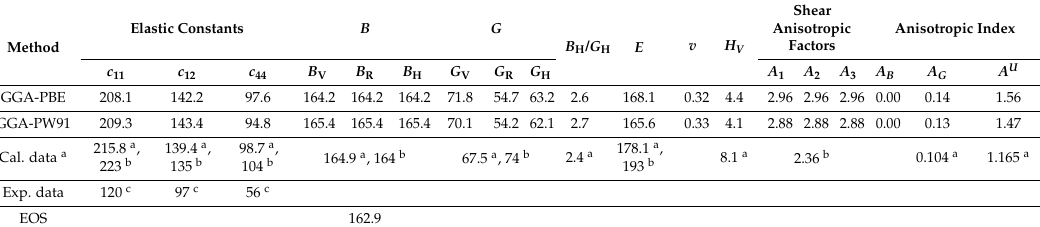
Table 2. Calculated independent elastic constants (GPa) compared to experimental and other theoretical values for the single crystalline AlNi 2 Ti intermetallic compound. Hereafter the mechanical modulus (GPa), Poisson’s ratio, Vicker’s hardness, shear anisotropic factors, and percent anisotropic index are also